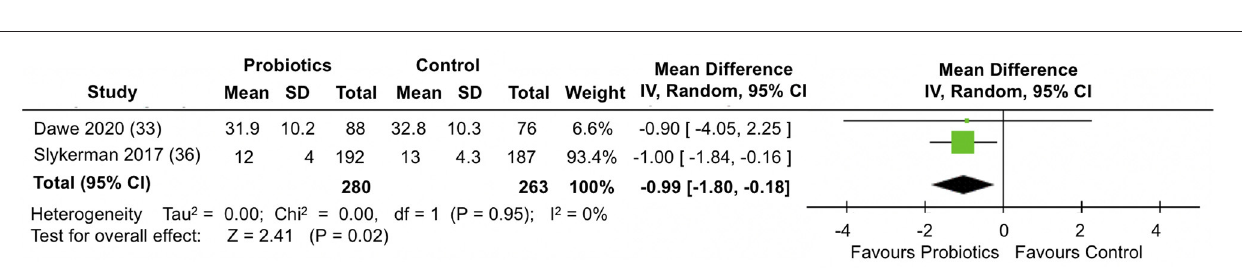
FIGURE 6 | Meta-analysis of the effect of probiotic supplementation on STAI-6 anxiety scores in the perinatal period.